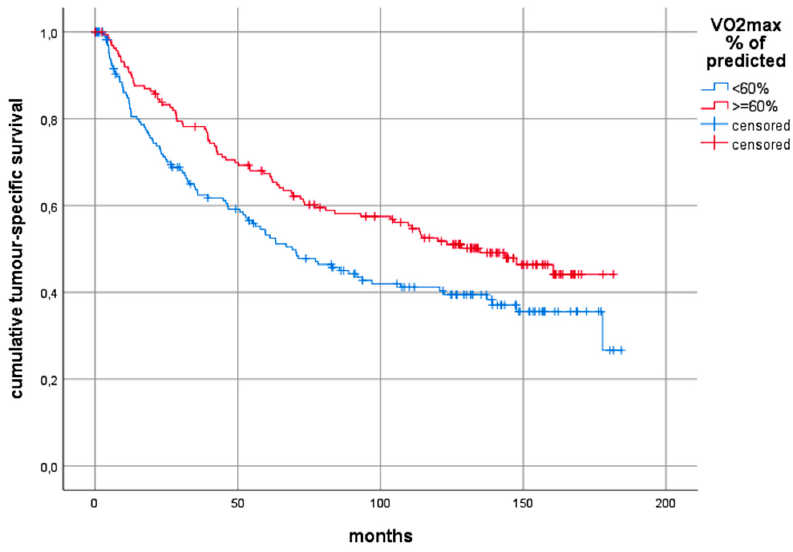
Figure 2. Kaplan–Meier curves comparing the tumour-related 10-year survival between those patients with predicted VO 2 peak >= 60% and those with predicted VO 2 peak < 60%. Log-rank test: chi 2 = 7.87, p = 0.005. Abbreviations: VO 2 peak: preoperative peak oxygen consumption.